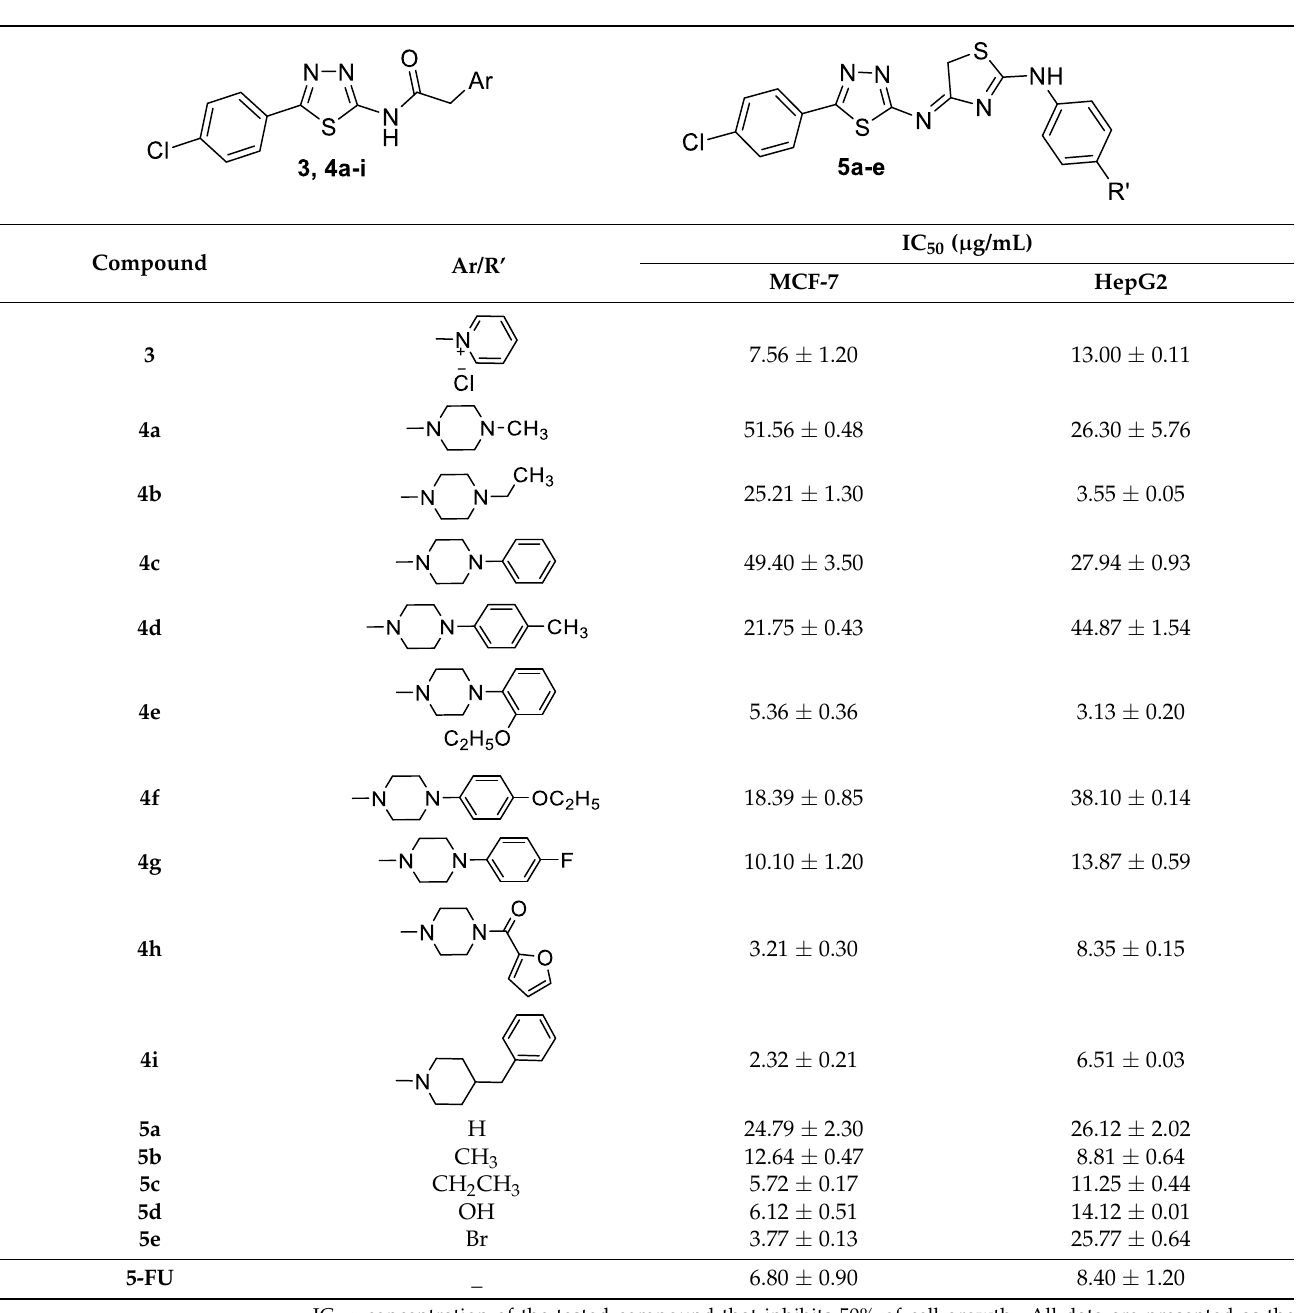
Table 1. The cytotoxic activities of compounds 3 , 4a-i , 5a-e, and 5-FU on MCF-7 and HepG2 human cancer cell lines.